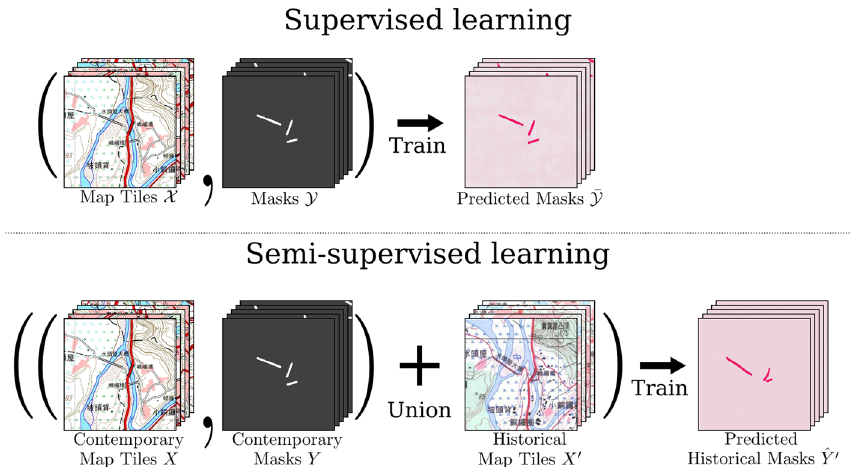
Figure 2. An illustration of supervised vs. semi-supervised learning concepts for applying machine learning for contemporary and historical map analysis. Here the analysis is on automatic bridge detection and segmentation. † The maps in this figure are provided by Taiwan Historical Maps System (https:// gis. sinica. edu. tw/ tiles erver/) with